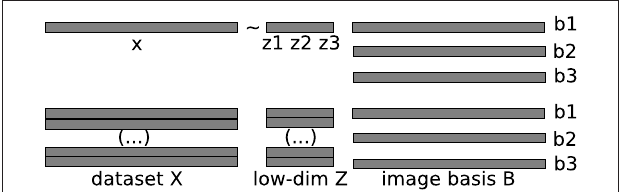
FIguRe A2 | Top : each brain image can be written as a row vector, and the combination as a linear combination of three row vectors. Bottom : A dataset contains many such patterns, forming a matrix X where rows are examples and whose low-dimensional representation is a matrix Z